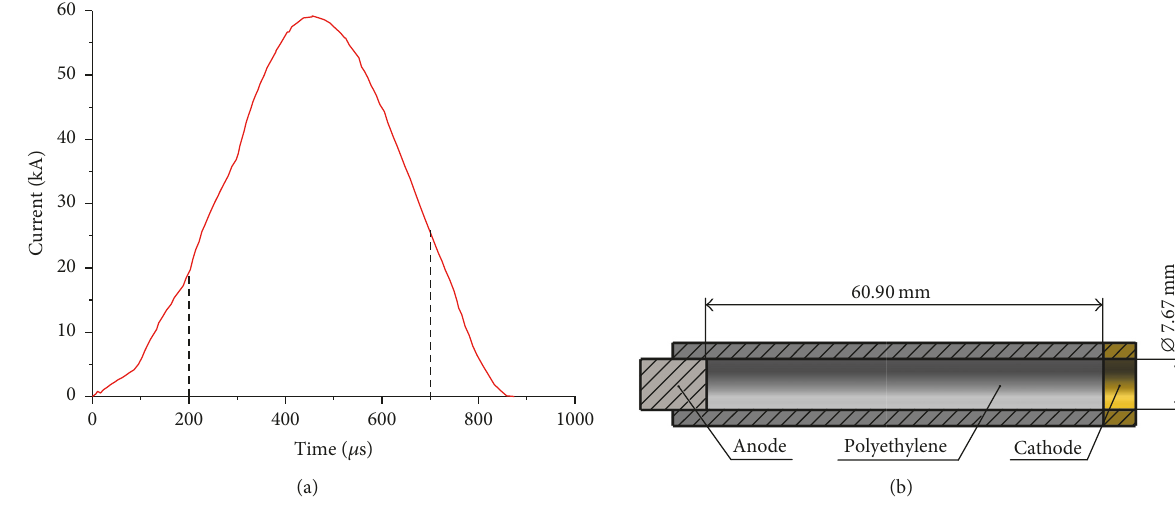
Figure 3: Inputting current profile and the geometry of the capillary discharge [4].